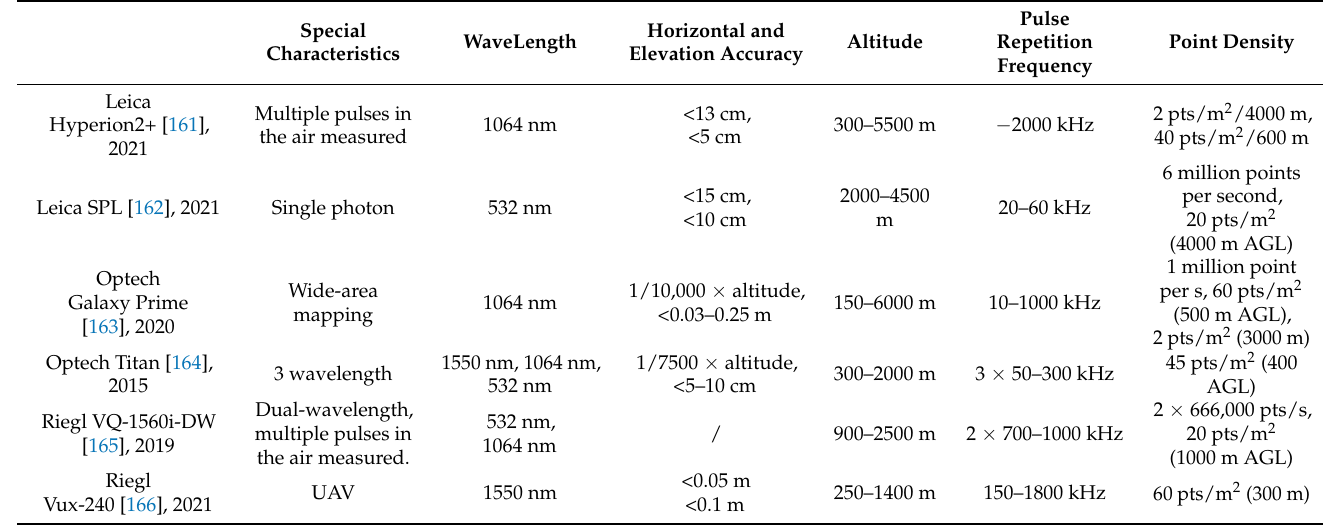
Table 3. Examples of currently available commercial ALS